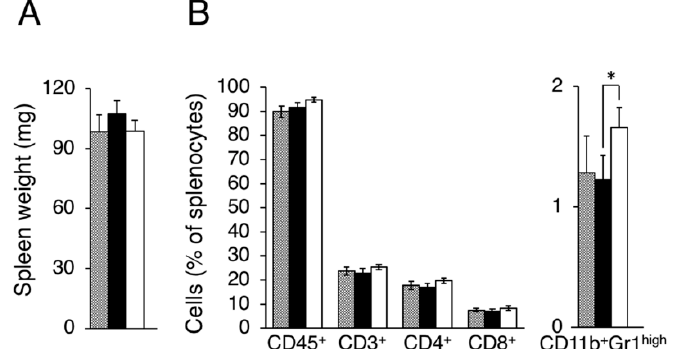
Figure A2. Evaluation of splenocytes in LM8 and Dunn bearing mice. Splenocyte populations were evaluated in tumor-free (gray column), Dunn (closed column) and LM8 (open column) bearing mice. ( A ) Spleen weight; ( B ) Leukocytes, Total T cell, Helper T cell, and Killer T cell, MDSCs were evaluated as CD45 + , CD3 + , CD4 + , CD8 + , CD11b + Gr1 high cells. *, p < 0.05 by Student’s t-test. Bars indicate standard error calculated using data from three independent trials.